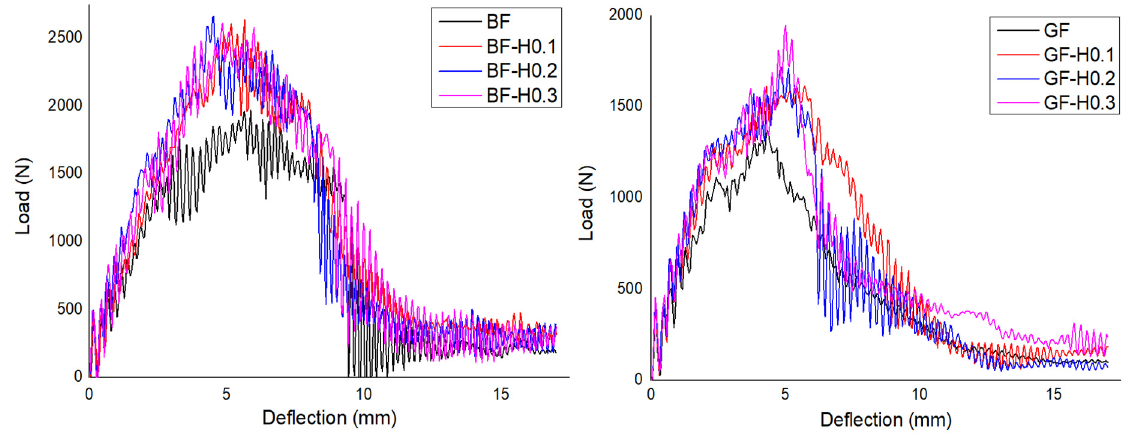
Figure 9. Typical load versus deflection responses of BFRP and GFRP embedded with hybrid nanofiller.